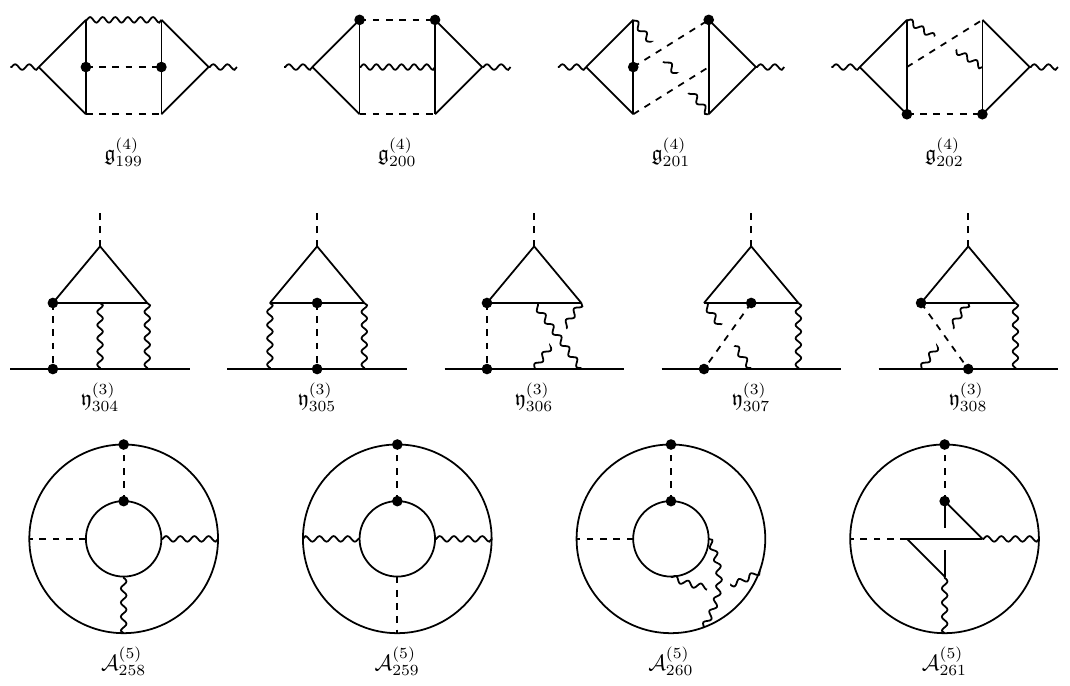
(4) and (cid:12) (3) , 5 contributions to (cid:12) aij AB